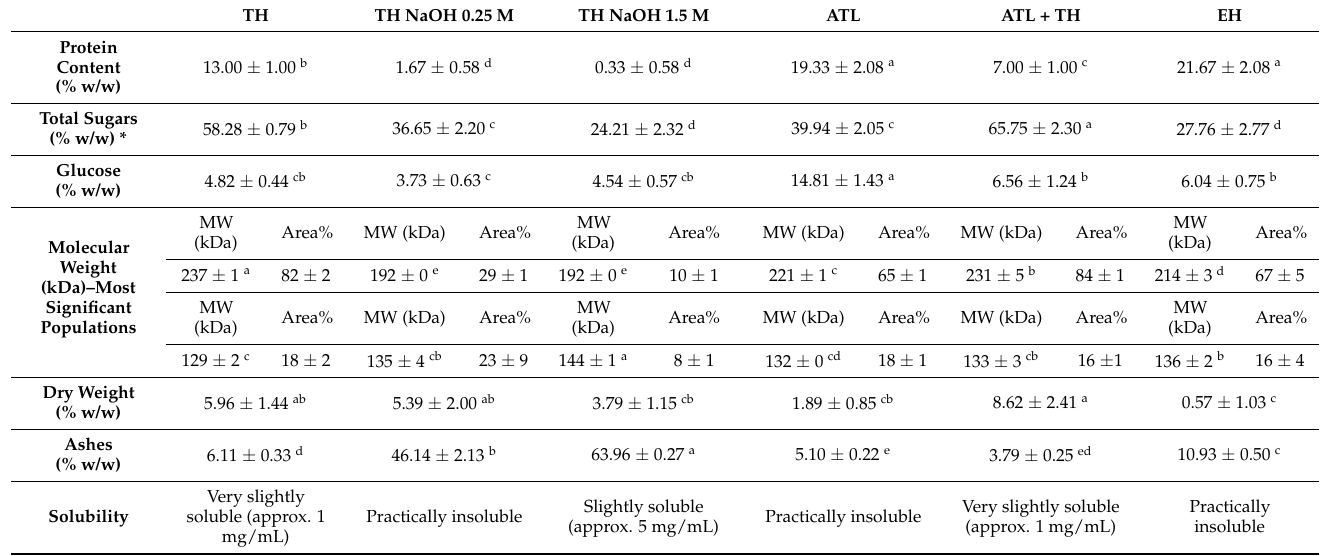
Table 3. Results of the physicochemical characterization of mannans extracts obtained by different extraction methods: Thermal Hydrolysis (TH); alkaline Thermal Hydrolysis (TH NaOH 0.25 M and TH NaOH 1.5 M); Autolysis (ATL); Autolysis followed by pH neutral Thermal Hydrolysis (ATL + TH); and Enzymatic Hydrolysis (EH). TH NaOH 0.25 M TH NaOH 1.5 M ATL ATL + TH EH